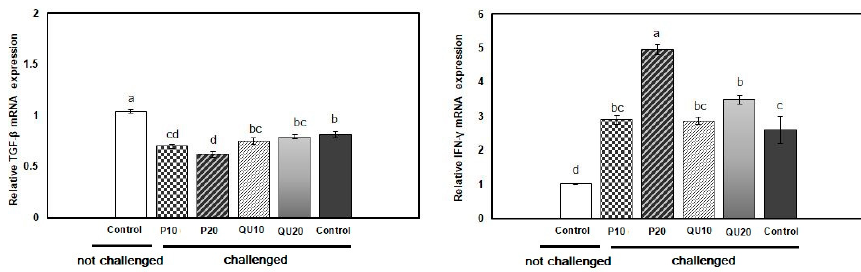
Figure 8. Relative expressions of TGF- β and IFN- γ mRNAs in the spleen tissue of A. sobria —challenged Nile tilapia in response to PP or QU supplementation at 10% and 20% for 45 days. The expression abundance of the genes was normalized against the EF-1 α internal control gene. Values are expressed as (mean ± SE, the values not sharing a common superscript letter (a, b, c, d) differ significantly at p < 0.05 by one-way. PP10: prickly pear fruit peel-supplemented group (10%), PP20: prickly pear fruit peel-supplemented group (20%), QU 10 : quinoa seeds—supplemented group (10%), QU 20 : quinoa seeds—supplemented group (20%).